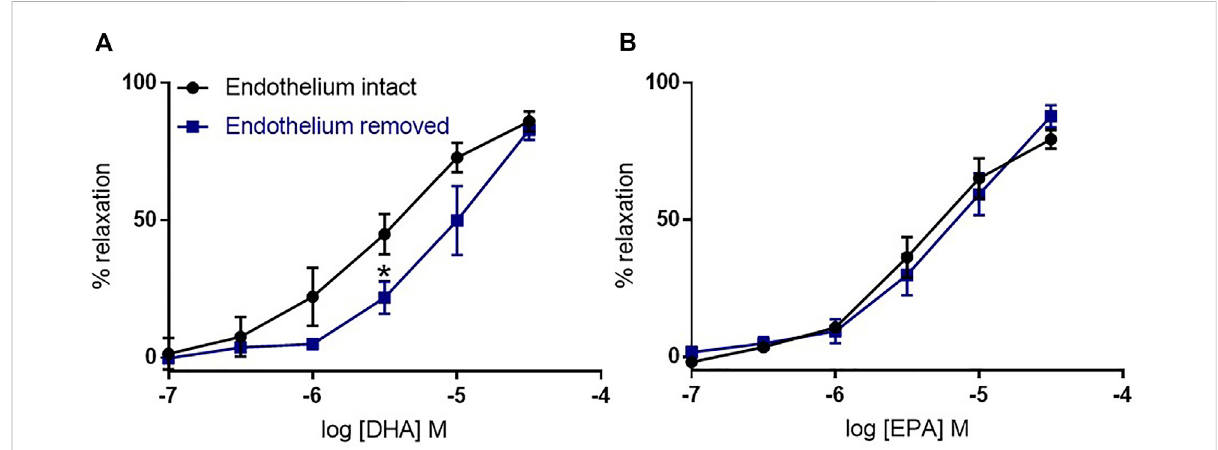
FIGURE 2 The effects of endothelium removal on DHA- and EPA-induced relaxation in mouse aortic rings preconstricted with U46619. (A) DHA- and (B) EPA-inducedrelaxationindenudedmouseaortacomparedwithintactringsfromthesameanimal. n =5,datarepresentedasmean±SEM.* p <